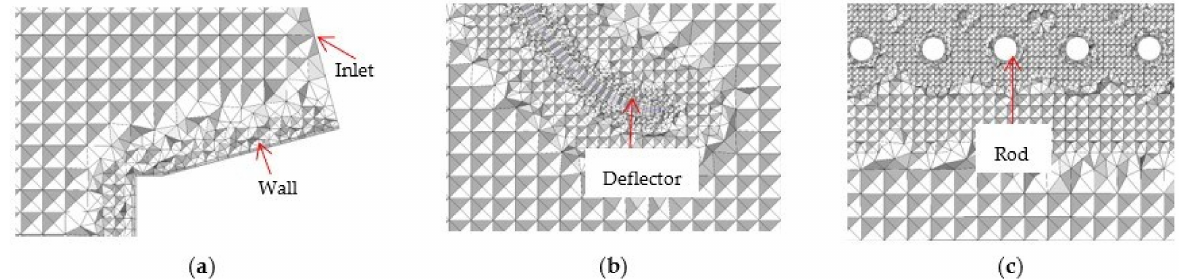
Figure 3. Boundary layer grids: ( a ) Grids of wall; ( b ) Grids of deflector; ( c ) Grids of